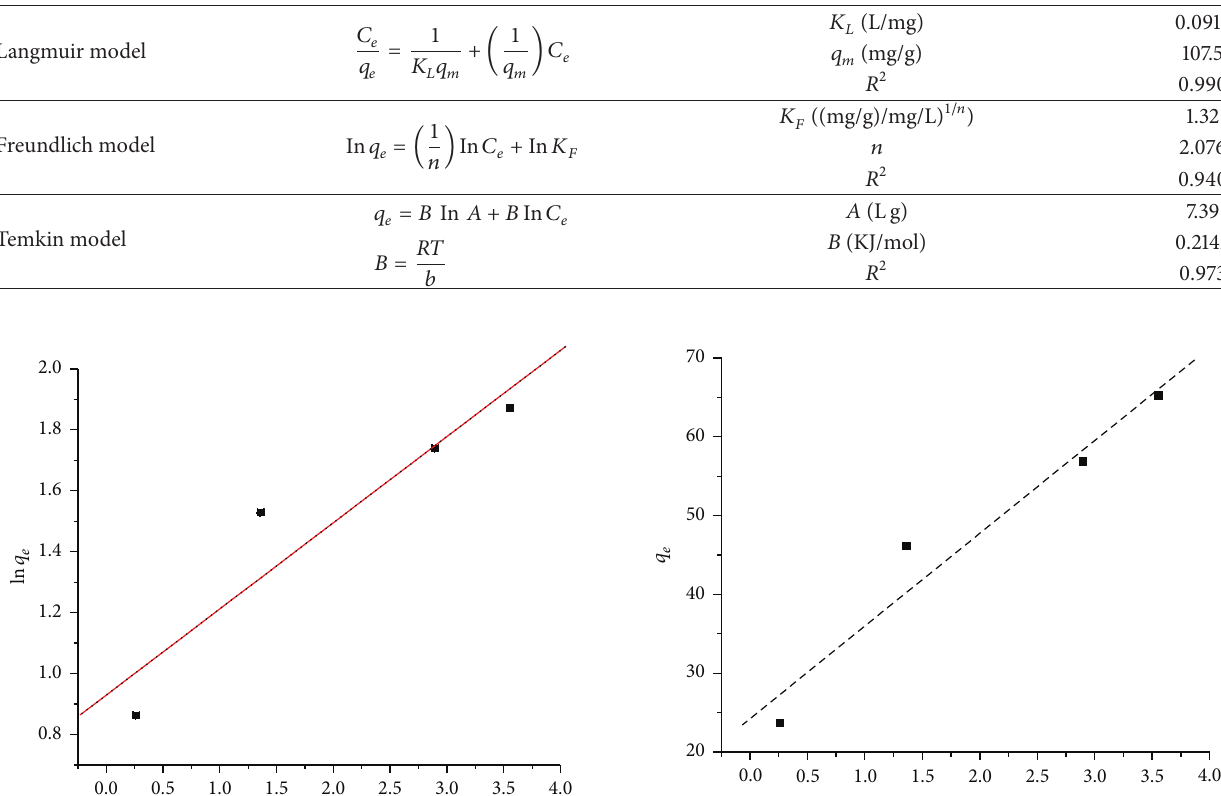
Table 1: Isotherms parameters for adsorption of Hg(II) onto ALP biomass at 303 K.